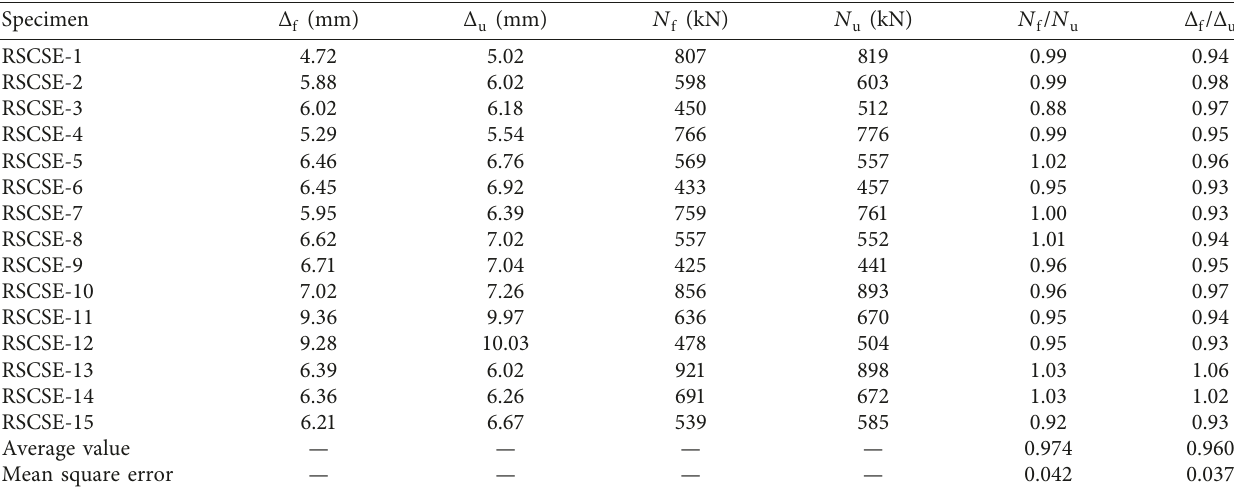
Figure 13: Typical FE model for the RSCFCST column: (a) integral model; (b) steel tube; (c) RSC; (d) wire frame of the integral Table 3: Comparison of FE prediction results and test data of specimen.